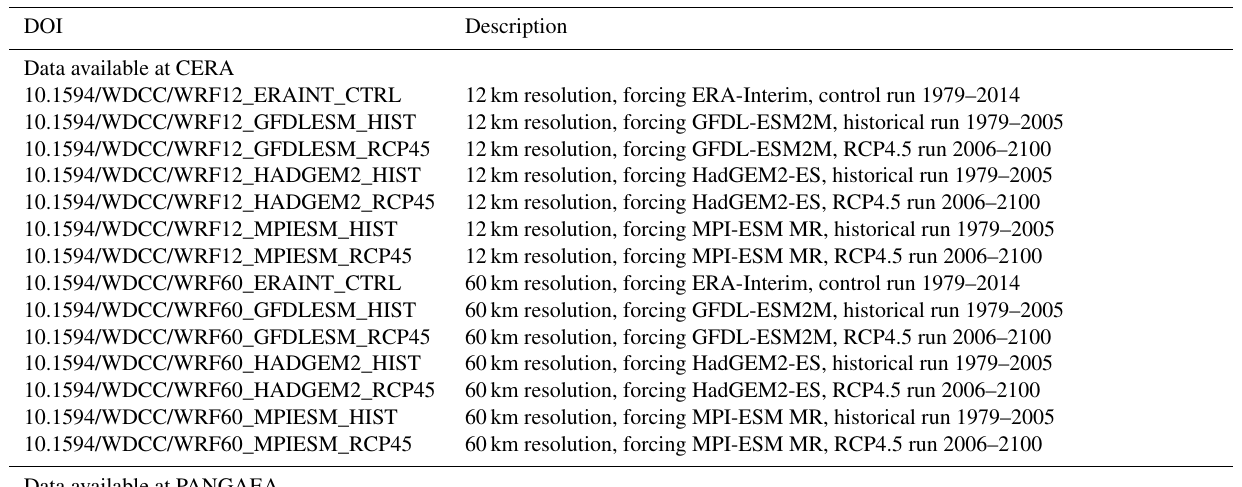
Table 1. Available data at CERA (https://cera-www.dkrz.de/WDCC/ui/Project.jsp?acronym=WASCAL, last access: 14 April 2018) and PANGAEA. Note that the previous URL opens a search mask on the CERA database for all available data sets (ensemble members), while the links behind the individual DOIs preselect the corresponding ensemble member. On PANGAEA, a single DOI is assigned to the data from all ensemble